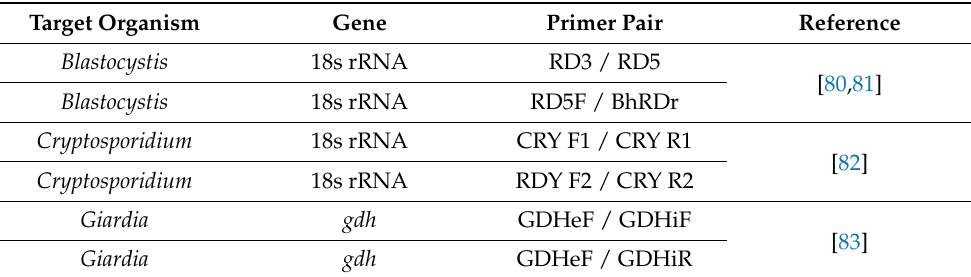
Table A1. Summary of PCR primers used in this study.